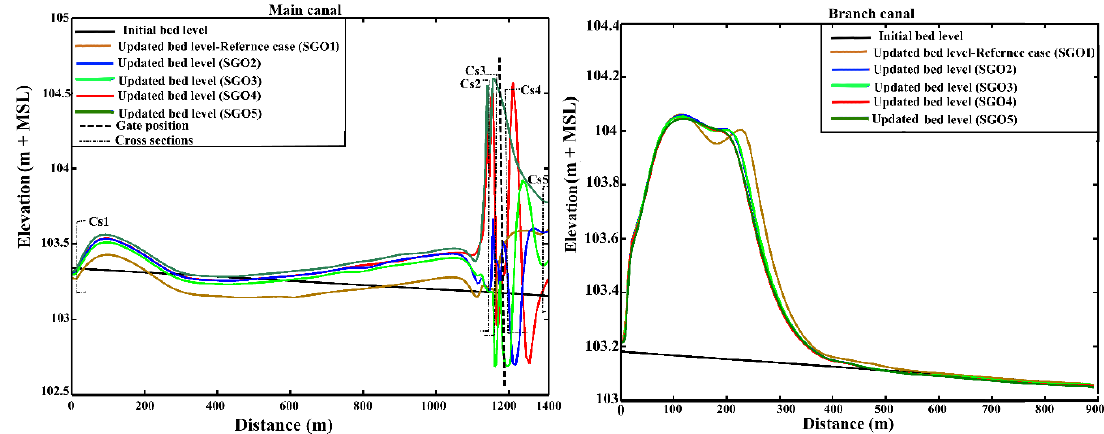
Figure 10. The bed level in scenarios with two gates opened.